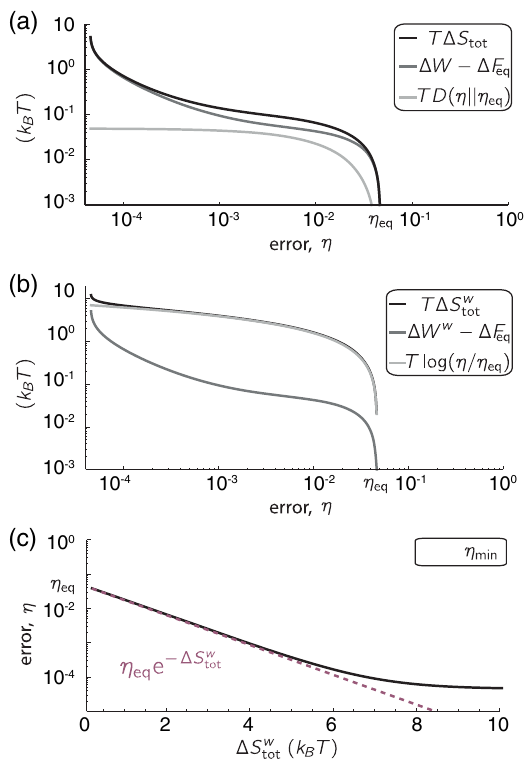
FIG. 4. Template-assisted polymerization without intermediate states. (a) Excess work Δ W − Δ F , entropy production, and eq Kullback-Leibler term of Eq. (2) as a function of the error. Notice that the excess work dominates over the information term. (b) Same terms as in (a) but for wrong monomers only. In this case, the information term dominates the entropy production. (c) Relation between error and entropy production of wrong monomers, together with thermodynamic (red dashed line) and hardware-specific (black dashed line) bounds. In all panels, the driving μ 10 is varied to vary the error. Parameters are δ 10 ¼ 10 T , Δ E